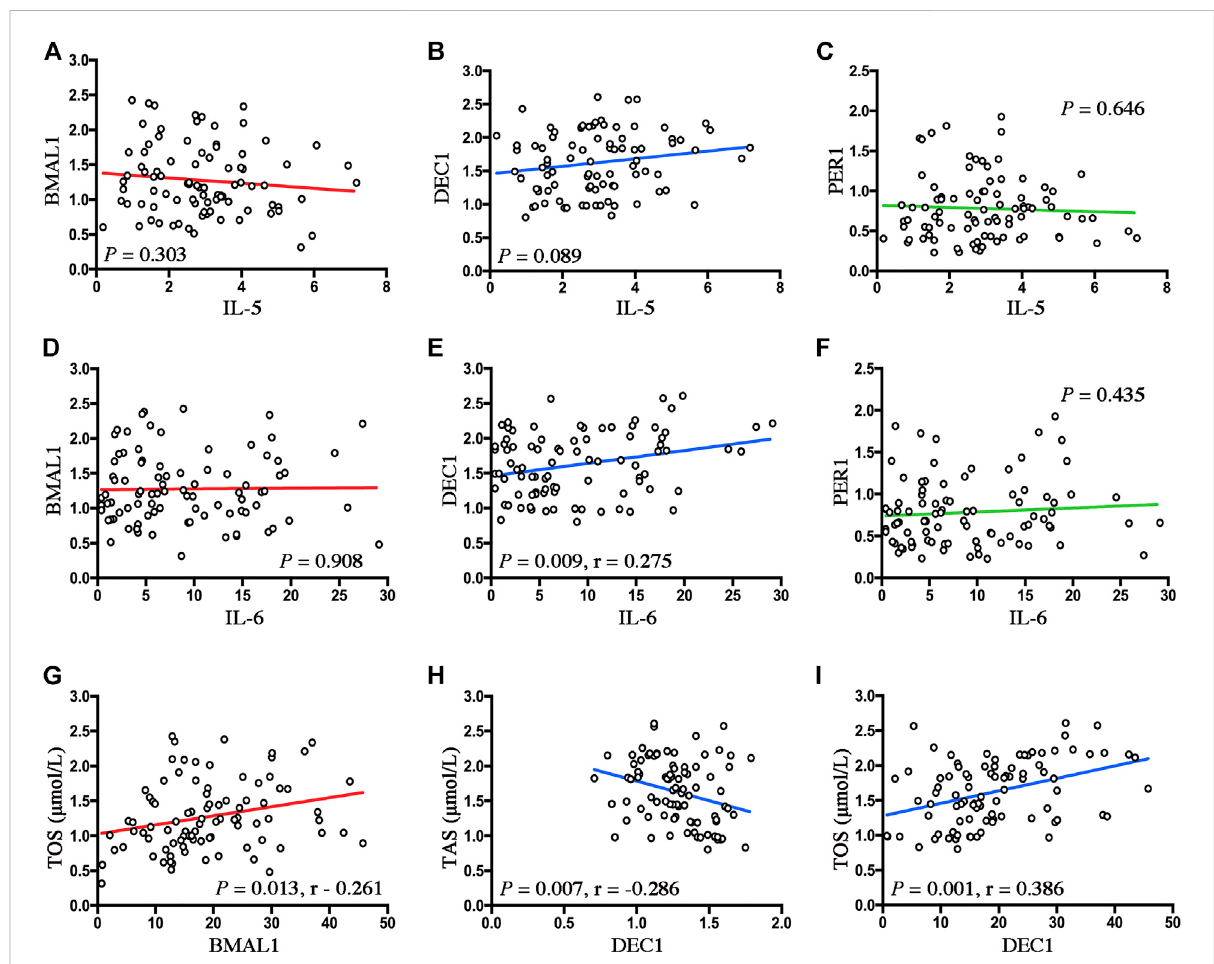
FIGURE 6 Disrupted clock genes re fl ect the in fl ammatory and oxidant status in OSA. (A – C) Linear regression between expression levels of Baml1 (A) , Dec1 (B) , Per1 (C) , and IL-5. (D – F) Linear regression among expression levels of Baml1 (D) , Dec1 (E) , Per1 (F) , and IL-6. (G – I) Linear regression between expression levels of Baml1 and TOS (G) ; Dec1 and TSA (H) ; Dec1 and TOS (I) .